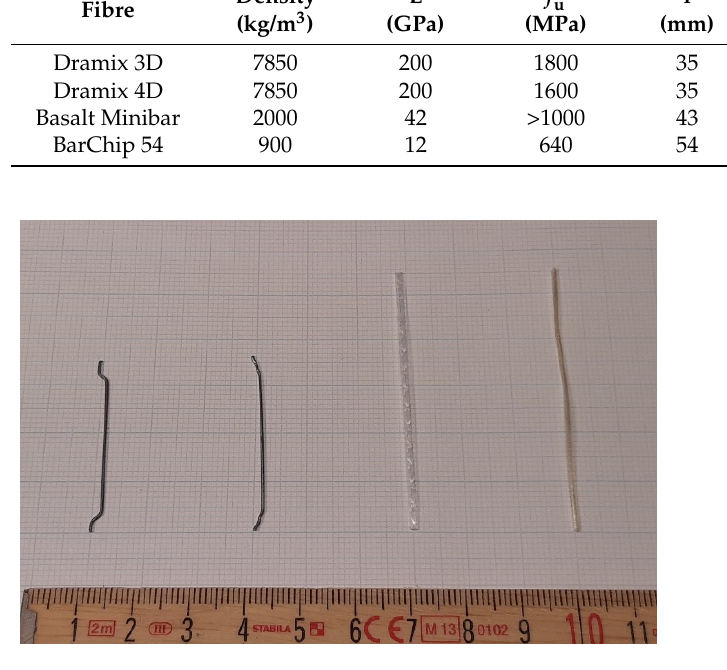
Figure 4. Fibres used in the experimental campaign, from left to right; Dramix 3D, Dramix 4D, BarChip 54, MiniBar. Metric scale in lower part of the picture.